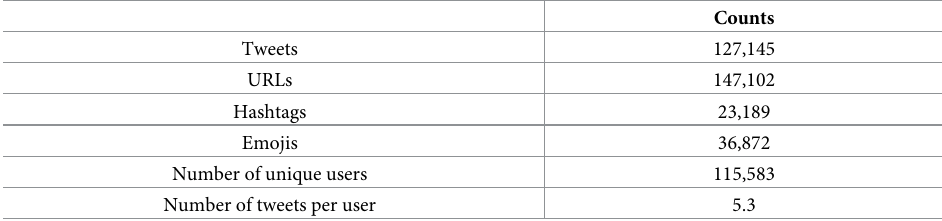
Table 3. Information on the data corpus collected after